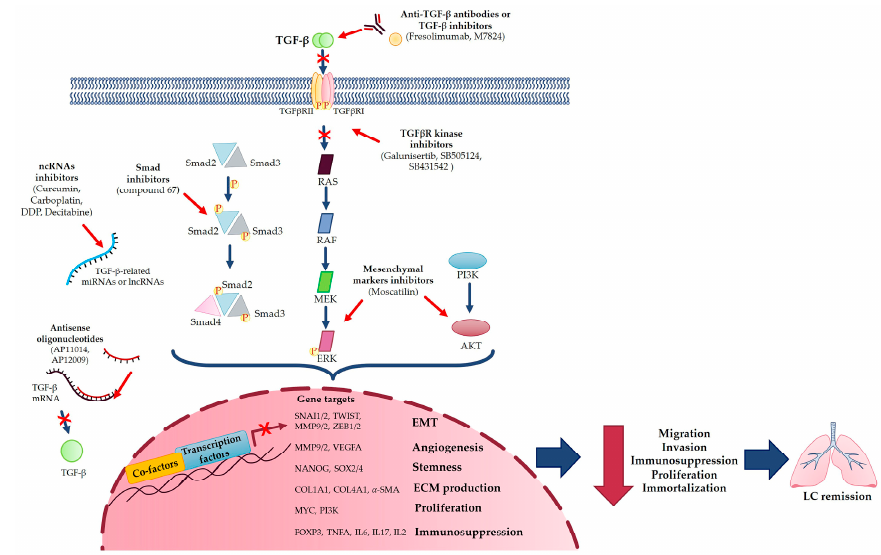
Figure 3. Targeting TGF- β signaling pathway in LC.